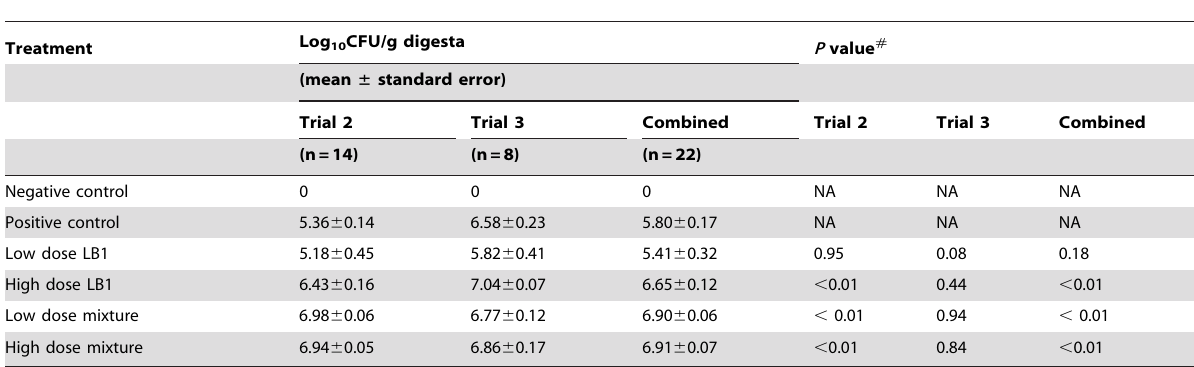
Table 4. Salmonella counts in the cecal digesta on days 3 and 4 post-infection in Trials 2 and 3 * .